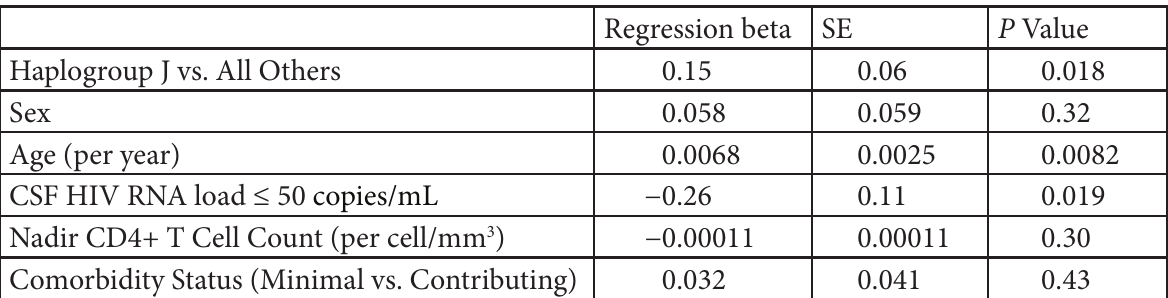
Table 3. Multivariate linear regression results for log CSF TNF-α with mitochondrial hap - logroup J for participants with undetectable HIV on ART (N =